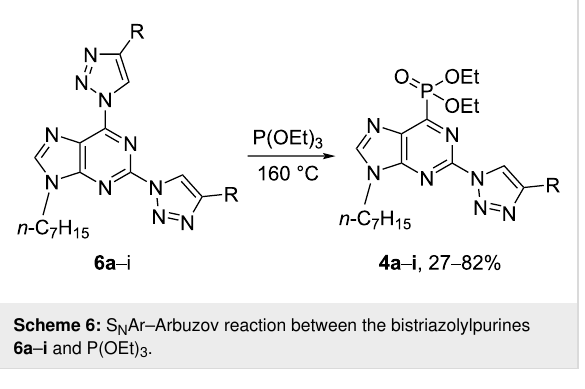
Table 2: Optimization of the S N Ar–Arbuzov reaction conditions for 6d → 4d according to Scheme 6.